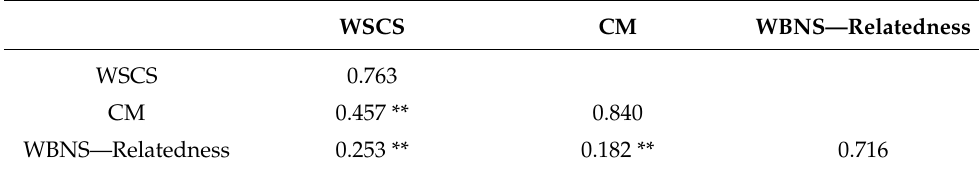
Table 7. Correlations of the WSCS testing convergent and concurrent